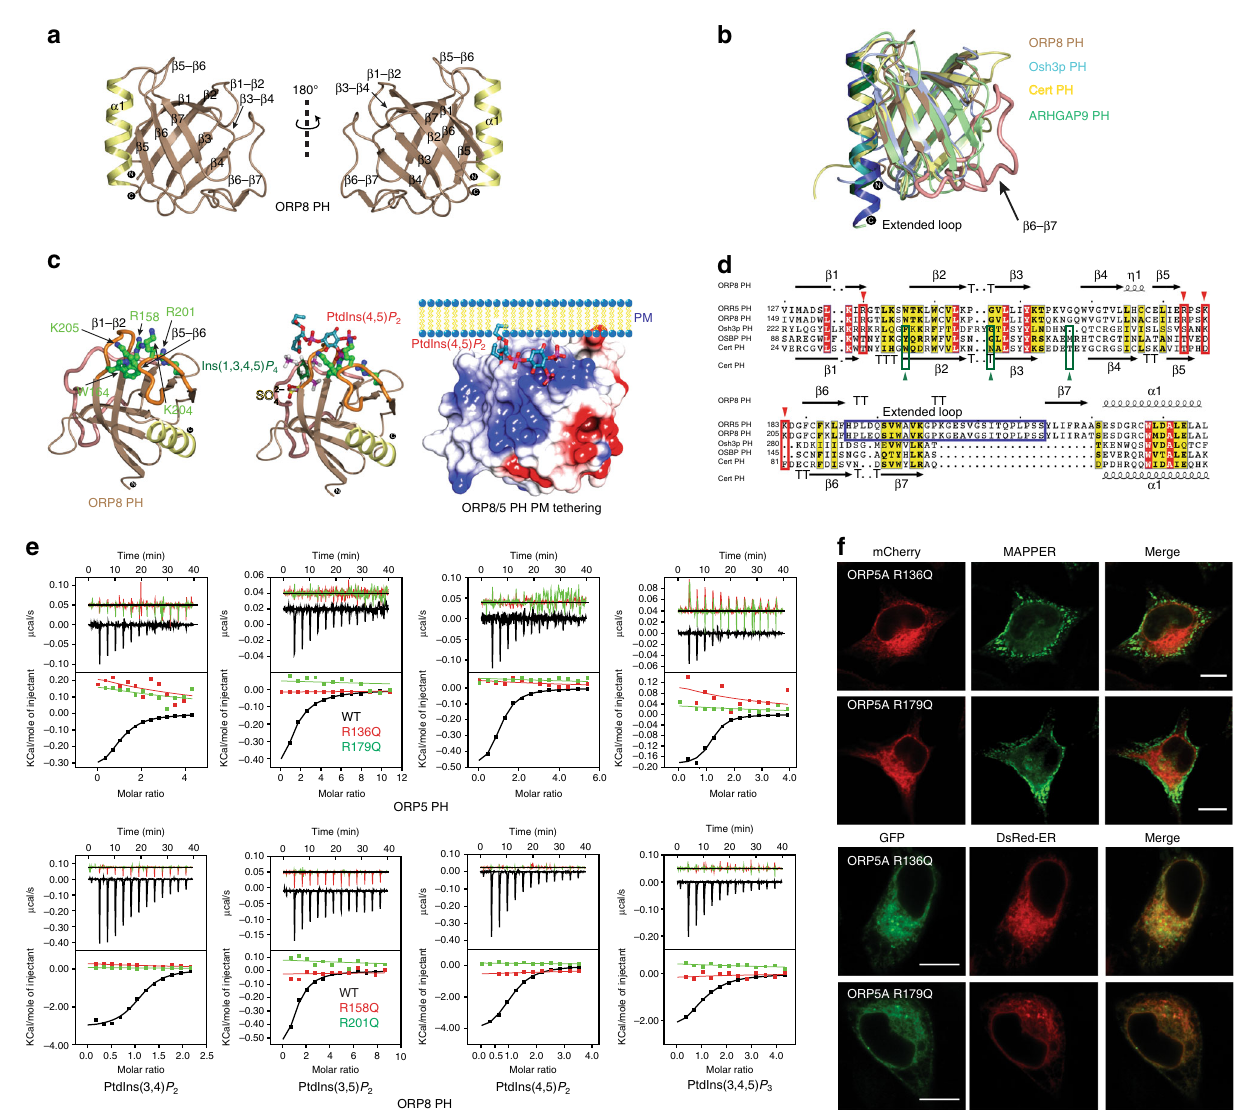
Fig. 2 Non-canonical PH domain – PtdIns P association is indispensable for translocation of ORP5 to ER – PM junctions. a Cartoon representation of the crystal structure of ORP8 PH domain. b Ribbon representation of the superposition of ORP8 PH ( brown ), Osh3p PH ( cyan ; PDB id: 4IAP) 20 , Cert PH ( yellow ; PDB id: 2RSG) 20 , and ARHGAP9 PH ( green ; PDB id: 2P0D) 20 . c Model of ORP8 PH domain constructed by superimposing PH domains of ARHGAP9 20 , Cert 20 , and ARNO 20 , highlights the putative PtdIns P -binding site (between β 1 – β 2 and β 5 – β 6). The electrostatic surface representation shows the presence of a positively charged cleft presented by the β 1 – β 2 and β 5 – β 6 loops for PtdIns P binding. Electrostatic potential rendered surface was computed in ccp4mg 45 , negatively charged surfaces are shown in red , whereas positively charged surfaces are blue in color, colors are contoured from − 0.5 V to +0.5. d A combined sequence alignment and secondary structure comparison of the PH domain of ORP5, ORP8, Osh3p, OSBP, and Cert. Secondary structure elements for ORP8 and Cert PH derived from the crystal structure are indicated above and below the alignment, respectively. Alignments were made with ESPript 2.2 (http://espript.ibcp.fr/ESPript/ESPript/) 46 . Red inverted triangles indicate the positively charged amino acids constituting the basic patch on the PH module of ORP8 and ORP5, which are absent in the other PH domains. Green triangles indicate the amino acids mediating PtdIns(4) P binding on the PH domains of Osh3p, Cert, and OSBP, which are absent in ORP5 and ORP8 PH domains. e The binding of ORP5 and ORP8 PH domain to PtdIns P s was measured by ITC. See Table 1 for a complete list of results. The binding of ORP5 R136Q, R179Q, ORP8 R158Q, R201Q, and WT ORP5 and ORP8 PH domains are shown in red , green , and black , respectively. Experiments were performed at 25 °C using 25 μ M protein and 500 μ M PtdIns P s. Top panels show raw data and bottom panels show integrated normalized data. f Co-localization of GFP and mCherry-tagged WT ORP5A and mutants (R136Q, R179Q) with MAPPER and DsRed-ER in HeLa cells. The GFP-fused ORP5A mutants (R136Q, R179Q) mainly overlap with DsRed-ER, but not MAPPER, suggesting that these mutants lose cortical ER localization. Bar = 10 μ